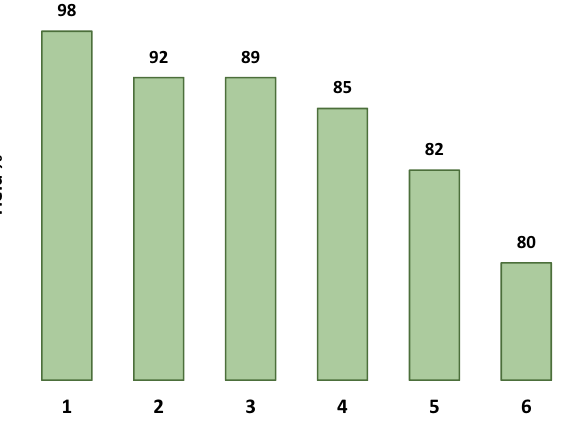
Figure 9 . Reusability of the LDH–APS–PEI–DTPA nanocomposite ( 1 ) in the reaction with 5a .